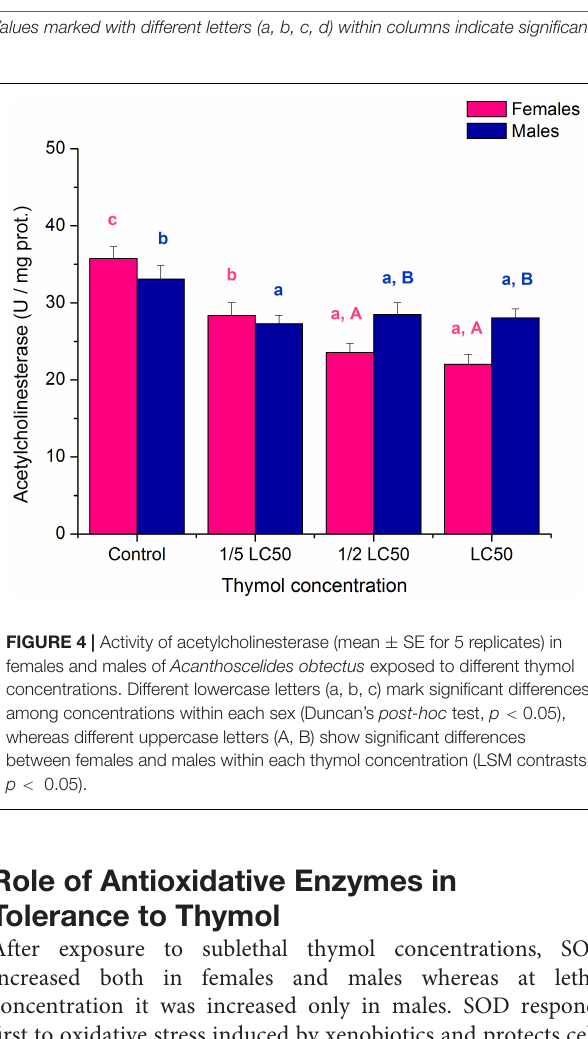
Values marked with different letters (a, b, c, d) within columns indicate significant differences among treatments (Duncan’s post-hoc test, p < 0.05).